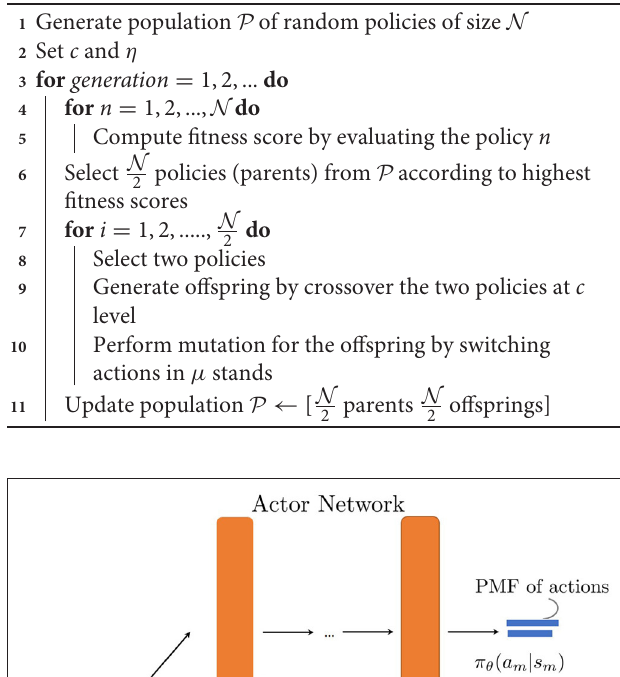
Algorithm 2: Genetic Algorithm implementation.